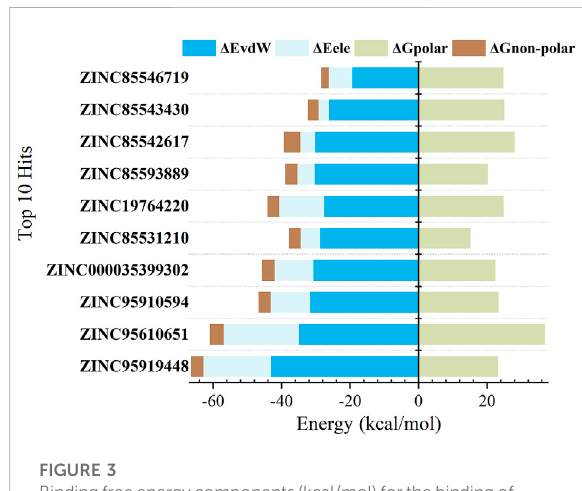
FIGURE 3 Bindingfreeenergycomponents(kcal/mol)forthebindingof top 10 compounds to RBD